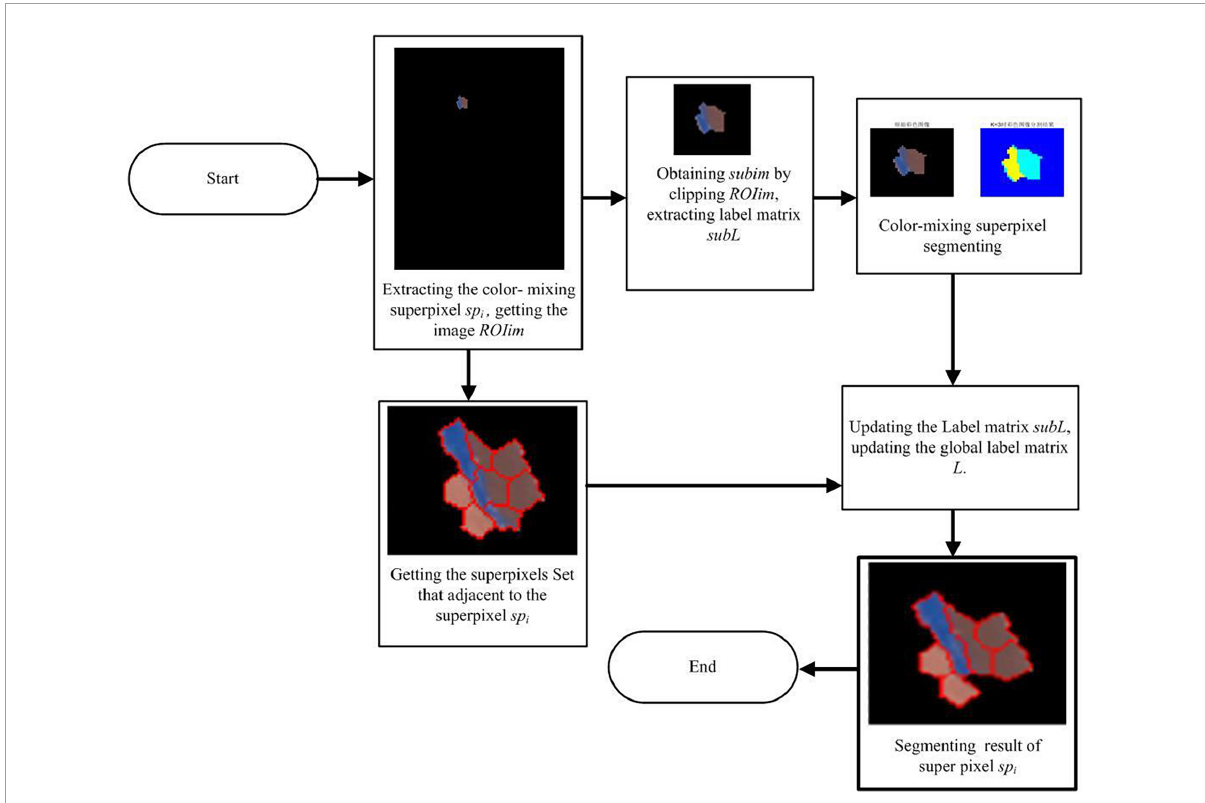
FIGURE3 Workflow of color-mixing superpixels